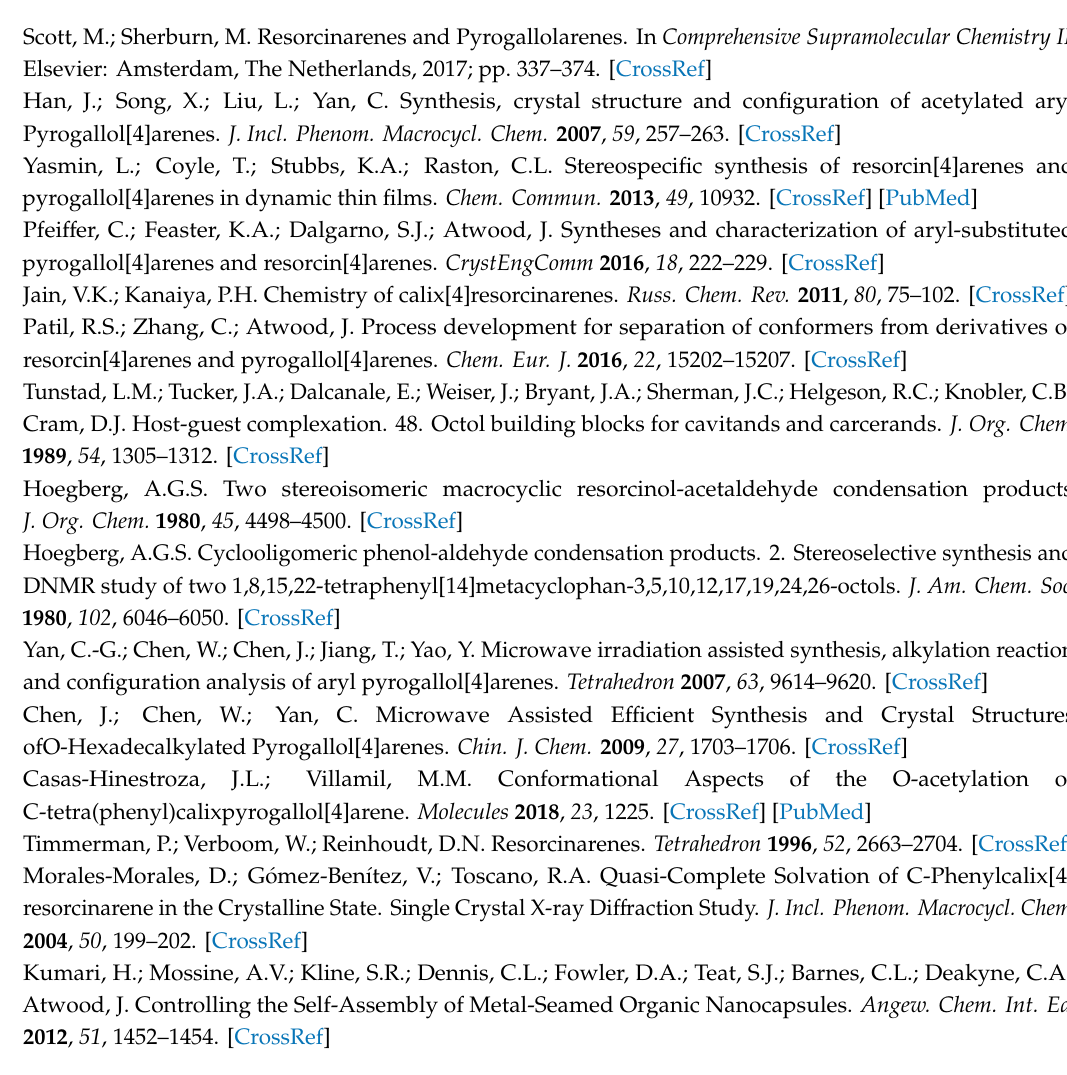
Figure S10: 1 H-NMR spectra of boat ( rccc )( 1a ), Figure S11: 1 H-NMR spectrum DMSO- d 6 conformational mixture( 2a and 2b ) and chair ( rctt )( 1b ), Figure S12: IR Spectrum of tetra(phenyl)-pyrogallol[4]arene( 2a ), Figure S13: 1 H-NMR spectrum-DMSO- d 6 of tetra(phenyl)-pyrogallol[4]arene( 2a ), Figure S14: 13 C-NMR spectrum-DMSO- d 6 of tetra(phenyl)-pyrogallol[4]arene( 2a ), Figure S15: Dynamic 1 H-NMR study for tetra(phenyl)-pyrogallol[4]arene( 2a ), Figure S16: IR Spectrum of tetra(phenyl)-pyrogallol[4]arene( 2a ), Figure S17: 1 H-NMR spectrum-DMSO- d 13 C-NMR spectrum-DMSO- d 6 of tetra(phenyl)-pyrogallol[4]arene( 2b ), Figure S18: 6 of tetra(phenyl)-pyrogallol[4]arene( 2b ), Figure S19: 1 H-NMR spectra of conformational mixture, boat ( rccc )( 2a ) and chair ( rctt )( 2b )